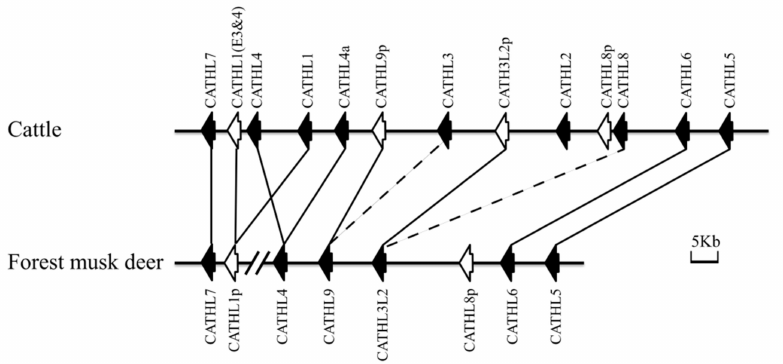
Figure 4. Genomic organization of the cathelicidin clusters in the cattle and forest musk deer. The position and transcriptional direction of each gene are represented by arrows. The solid arrows refer to functional genes, whereas open arrows refer to pseudogenes. A broken line in a gene cluster is an indication of a gap in the genomic DNA sequence. The orthologous genes are linked using solid lines, and paralogous genes are connected with dashed lines.